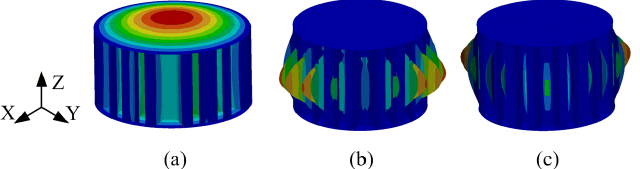
Figure 11. Simulated mode shapes for the A 2 -type panel: ( a ) mode at 5149 Hz, ( b ) mode at 6818 Hz, ( c ) mode at 6854 Hz.